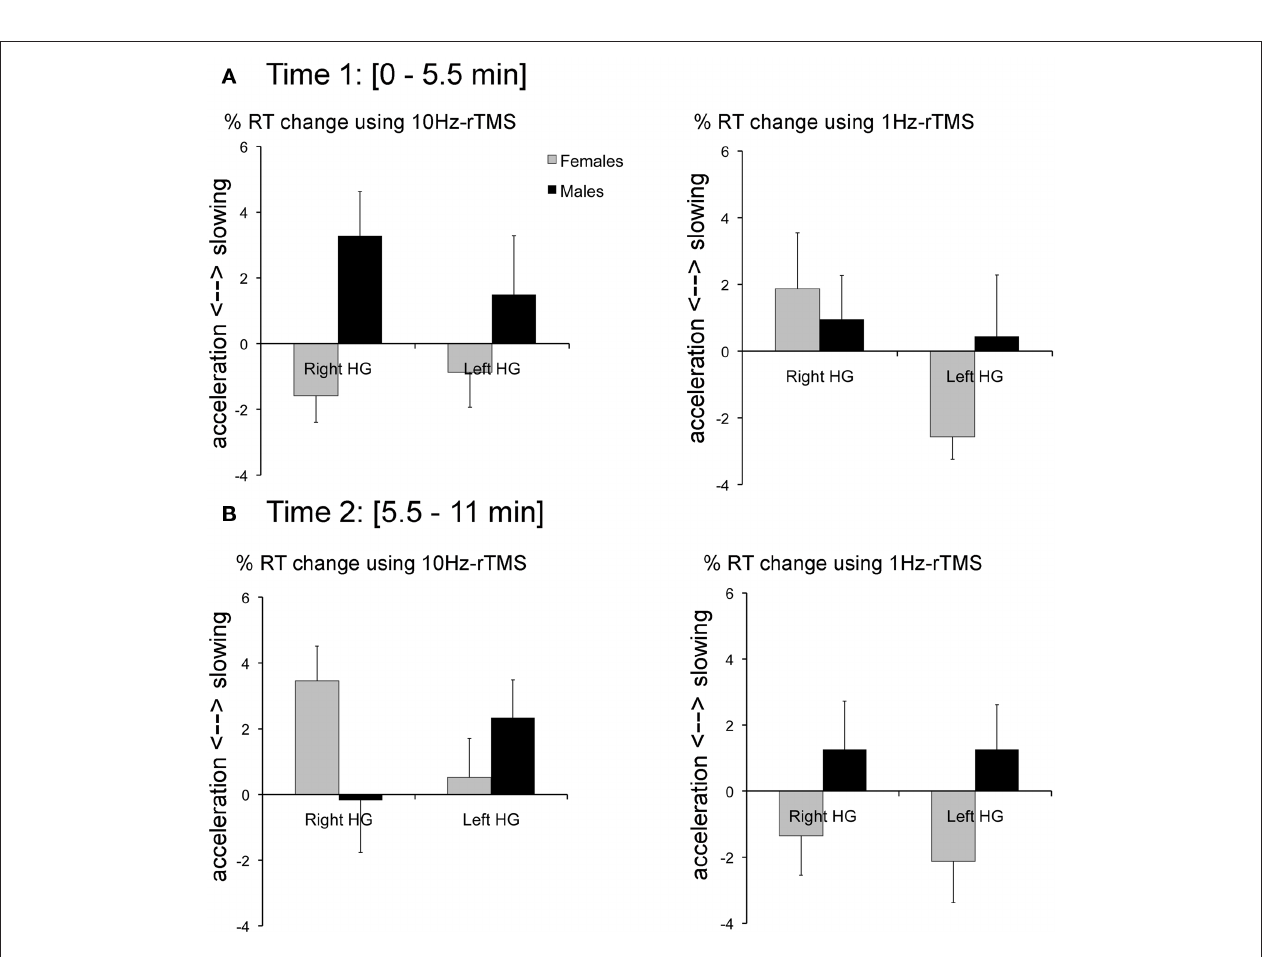
targeting the right or left HG calculated relative to rTMS applied over the Vertex for the female group (black bars) and the male group (gray bars). (Right) %RT change with 1 Hz-rTMS targeting the right or left HG calculated relative to rTMS applied over the Vertex for the female group and the male Error bars reflect SE of the mean adjusted to correctly reflect the variance in the within-subject design (Loftus and